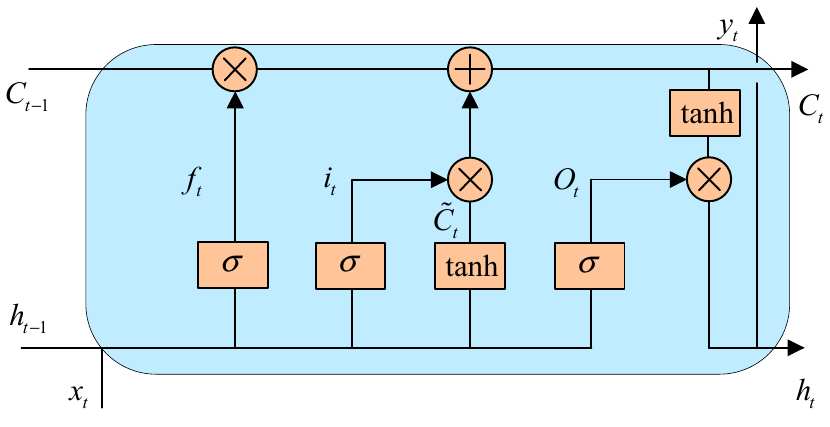
Figure 2. LSTM network model structure diagram.